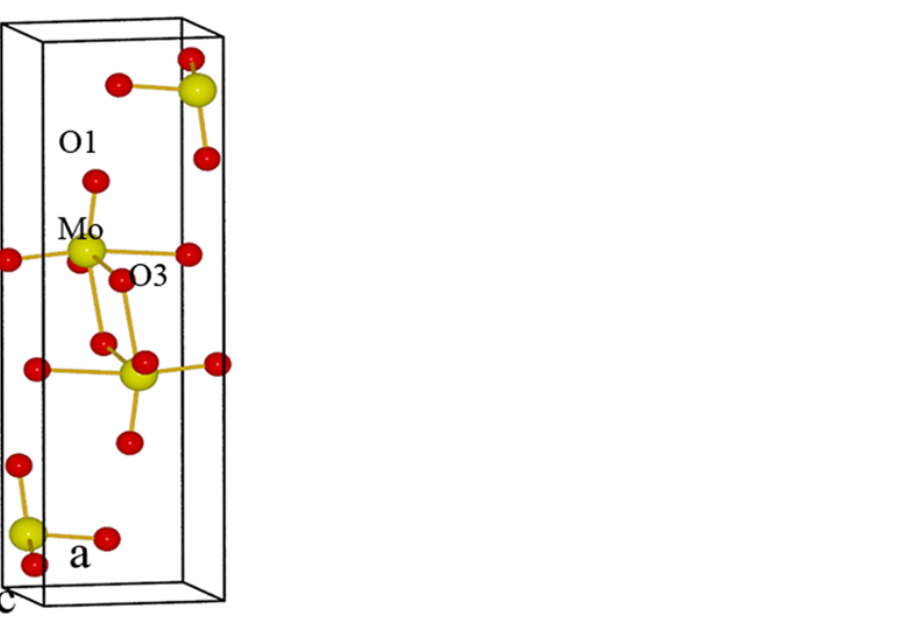
Figure 3. The crystal structure of MoO 3 unit cell. Reprint from [130]. Copyright (2021), with permission from Springer Nature.